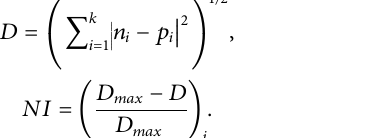
Frontiers in Energy Research |